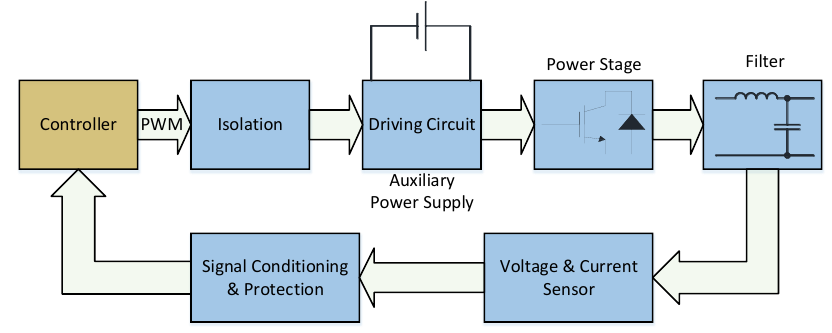
Figure 2. Controller structure for primary